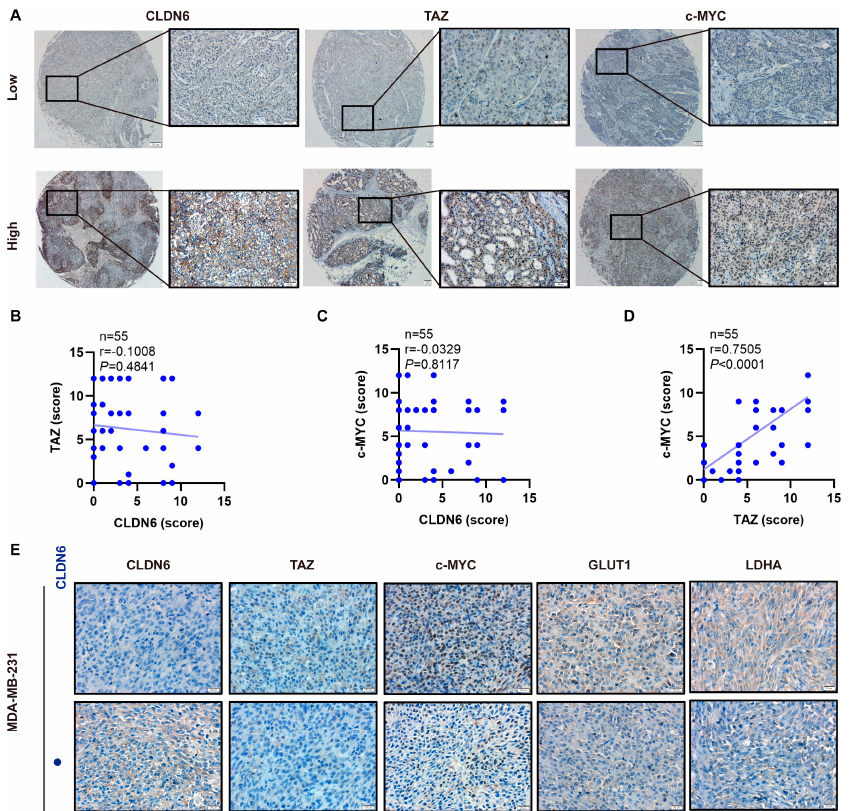
Figure 5. CLDN6 inhibits aerobic glycolysis by down-regulating c – MYC and its target genes GLUT1 and LDHA. RT-PCR ( A , B ) and WB ( C , D ) analysis of the impact of CLDN6 on c – MYC in MCF – 7 and MDA – MB – 231 cells. ( E–G ) RT – PCR and WB analysis of the effect of CLDN6 on GLUT1 and LDHA in MCF – 7 and MDA – MB – 231 cells. ( H–J ) RT – PCR and WB analysis of the effect of c – MYC on GLUT1 and LDHA in MCF – 7/CLDN6 and MDA – MB – 231/CLDN6 cells. Glucose uptake assays ( K ), lactate production assays ( L ), and ATP production assays ( M ) with MCF – 7/CLDN6 and MDA – MB – 231/CLDN6 cells expressing vector or c – MYC. ns, no significance, * p < 0.05, ** p < 0.01, *** p < 0.001. , CLDN6 or c – MYC overexpression.